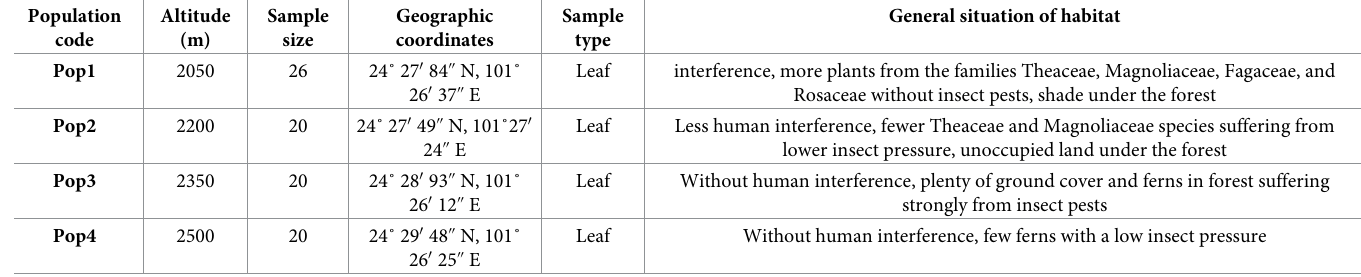
Table 1. General situation of land samples at different altitudes. Population